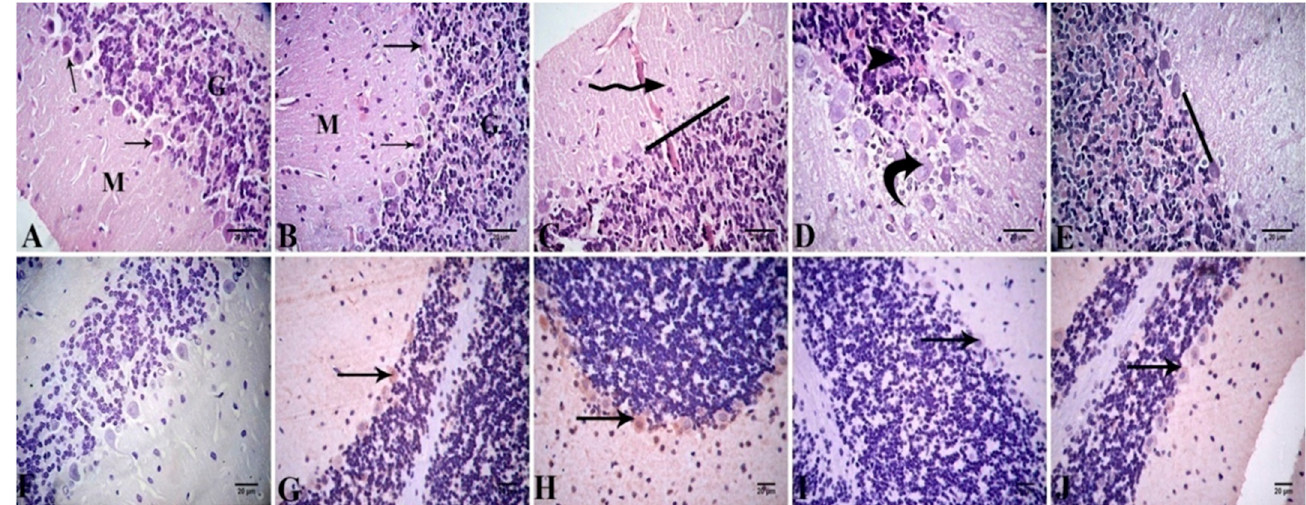
Figure 7. ( A – E ) Photomicrograph of cerebellar tissue sections stained with H&E revealing normal histological structure in control ( A ) and Alhagi-administered rats ( B ), molecular layer (M), Purkinje cell layer (arrows), and granular layer ( G ). The lead-treated rats show congested cerebellar cortex (zigzag arrow) and loss of Purkinje cells in some areas (____) ( C ), Purkinje cells coalesce together (curved arrow), and pyknotic nuclei of granule cells (arrow head) ( D ). The lead + Alhagi-exposed rats demonstrate loss of Purkinje cells in some areas (____) ( E ). ( F – J ) Photomicrograph of the cerebral tissue sections revealing Bcl-2 immunoexpression (arrows) as the following: negative in the negative control ( F ), mild in the control ( G ), moderate in the Alhagi-administered rats ( H ), negative to weak in the lead-intoxicated rats ( I ), and mild in the lead + Alhagi-exposed rats ( J ).